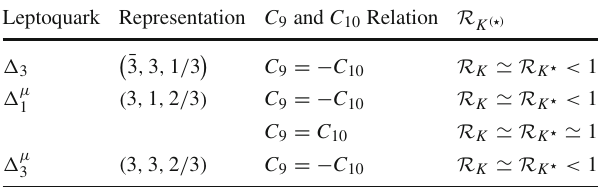
Table 2 Relationships implied for the Wilson coefficients C 9 , 10 , and the corresponding predictions for R K ((cid:2)) , for the three leptoquarks we consider Leptoquark Representation C 9 and C 10 Relation R K